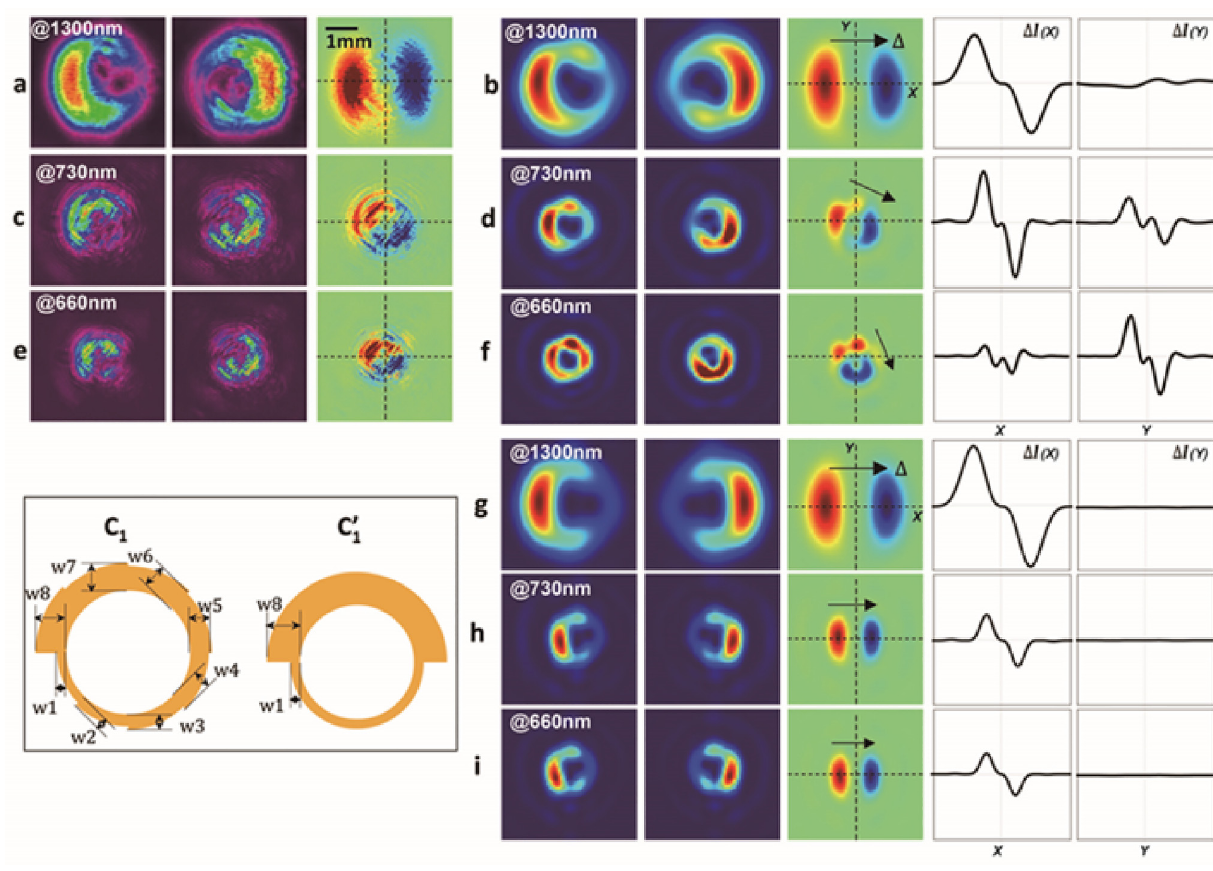
Figure 6: Wavelength-dependence of a spin-dependent beam separation. Wavelength-dependence of a spin-dependent beam separation in C 1 h TA-CGSM metasurface is shown at 1300 nm, 730 nm, and 660 nm. (a), (c), (e), Experimental measurements and (b), (d), (f), FDTD calculations for C 1 h TA-CGSM. g,h,i, FDTD calculations for C 1 h ′ metasurface with incident Gaussian beam propagation along + (cid:11) z